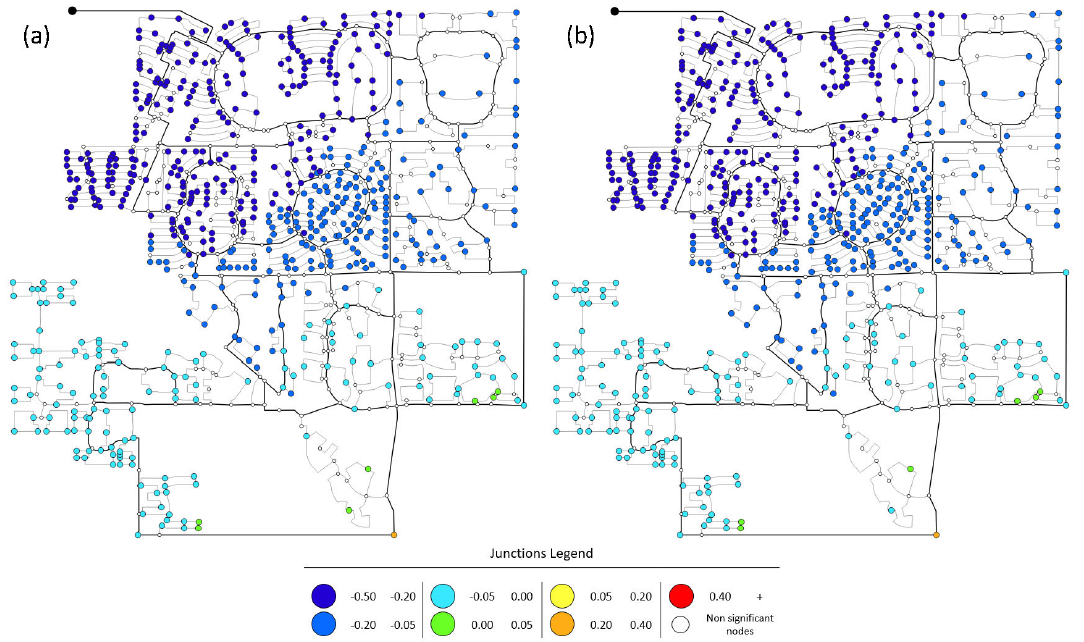
Figure 6. Graphs containing the local pressure head surplus index, for peak coefficient P c = 2. ( a ) DDA simulation result. ( b ) PDA simulation result. For a peak coefficient equal to 2, the only node in pressure deficit is the number 1038.